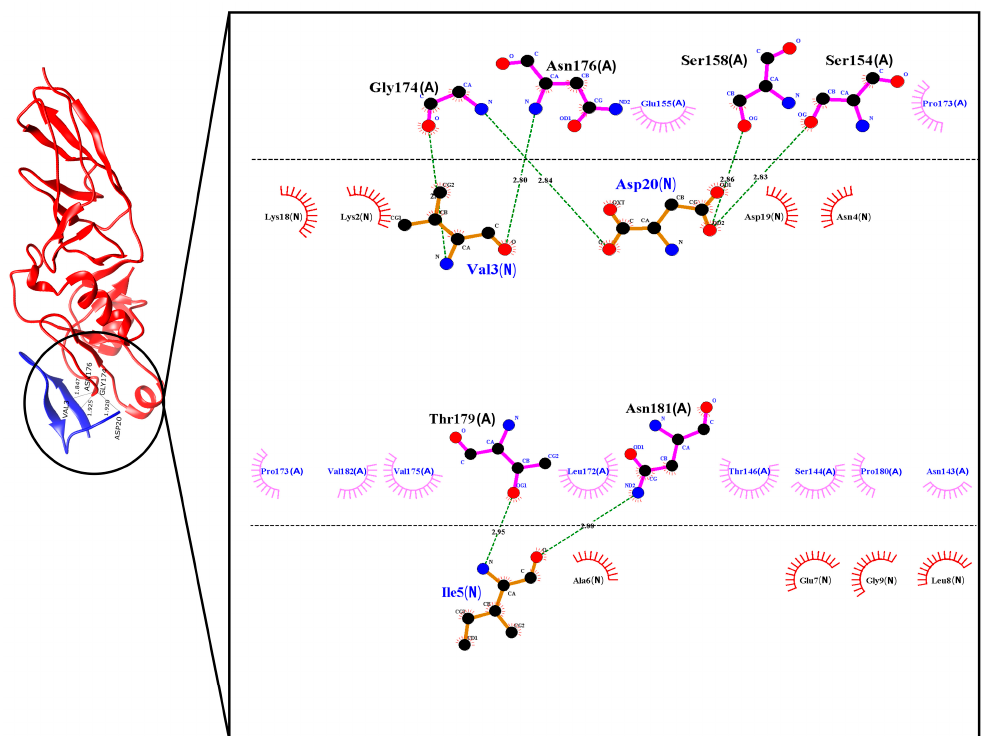
Figure 3. Complex between the peptide model obtained with PEP-FOLD and the original structure of the Intimin protein, predicted by the FlexPepDock program.